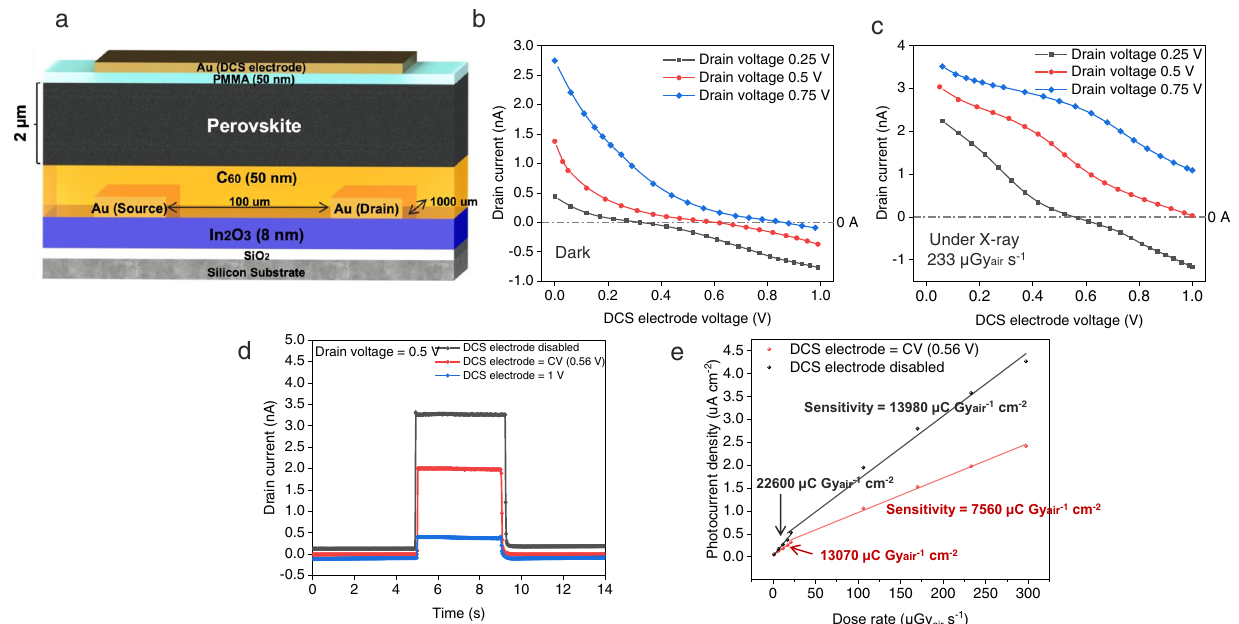
Fig. 3 | Schematic,current – voltage characteristics and sensitivityofDCS X-ray detectors.a SchematicofDCSX-raydetectors. b Current – voltagecurvesinterms of DCS electrode voltages and drain currents in dark conditions. The drain cur- rent decreases with increased DCS biases. c Current – voltage curves in terms of DCS electrode voltages and drain currents when exposed to X-ray. d X-ray